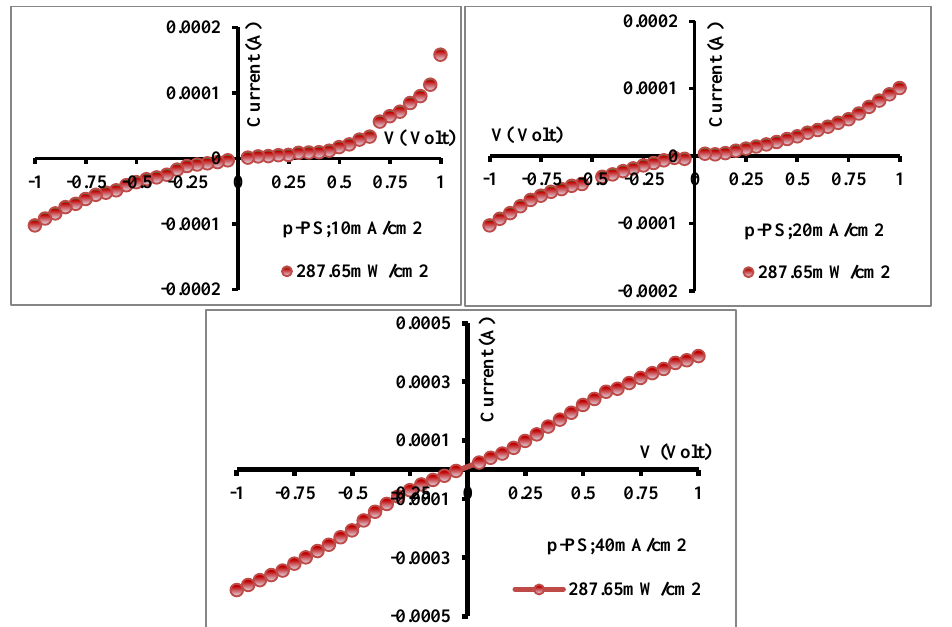
Fig.7: I-V characteristics under white light for p-PS at current densities (10, 20 and 40) mA/cm 2